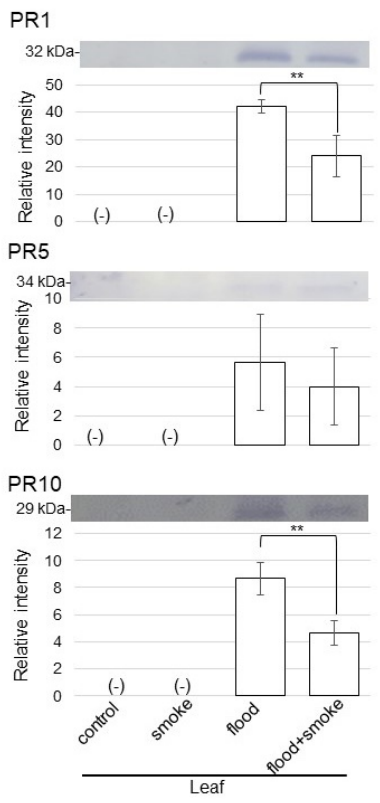
Figure 8. Immunoblot analysis of the proteins involved in biotic stress in wheat treated with the plant-derived smoke solution under flooding stress. Proteins extracted from the leaves of wheat seedlings were separated on SDS-polyacrylamide gel by electrophoresis and transferred onto membranes. The membranes were cross-reacted with anti-PR1, PR5, and PR10 antibodies. A staining pattern with Coomassie-brilliant blue was used as a loading control (Figure S1). The integrated densities of the bands were calculated using ImageJ software. The data are presented as mean ± SD from 3 independent biological replicates (Figures S3–S5). Asterisks indicate significant changes in the relative intensity of signal band in the plant-derived smoke solution under flooding compared to only flooding according to the Student’s t -test (**: p < 0.01).